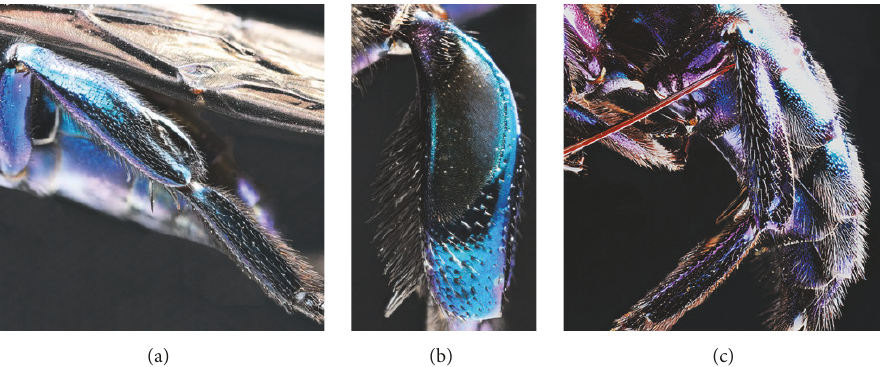
Figure 6: Male A. caerulea , (a), (b), lateral view of hindleg and mesotibial tuft; (c) female, lateral view, showing metatibial scoop.